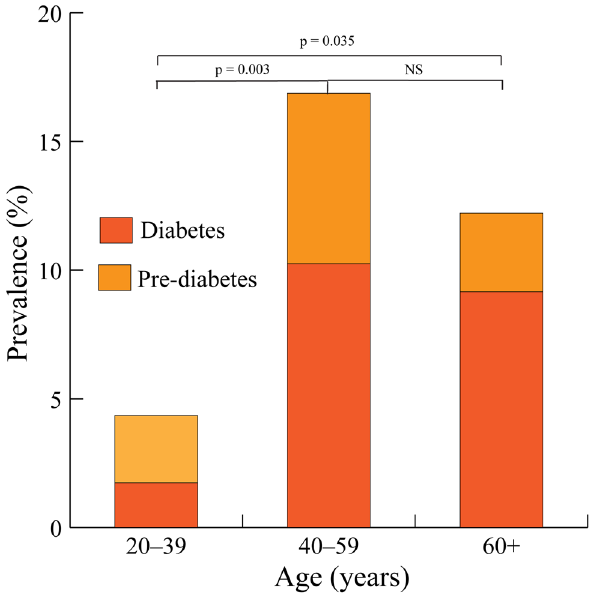
Figure 3. Prevalence of pre-diabetes and diabetes by subject age, Nièna, Mali, 2021. The bottoms and tops of the stacked columns represent diabetes and pre-diabetes groups, respectively. Statistically significant differences were observed for the 20–29 versus 40–49 and 30–39 versus 40–49 age group comparisons.